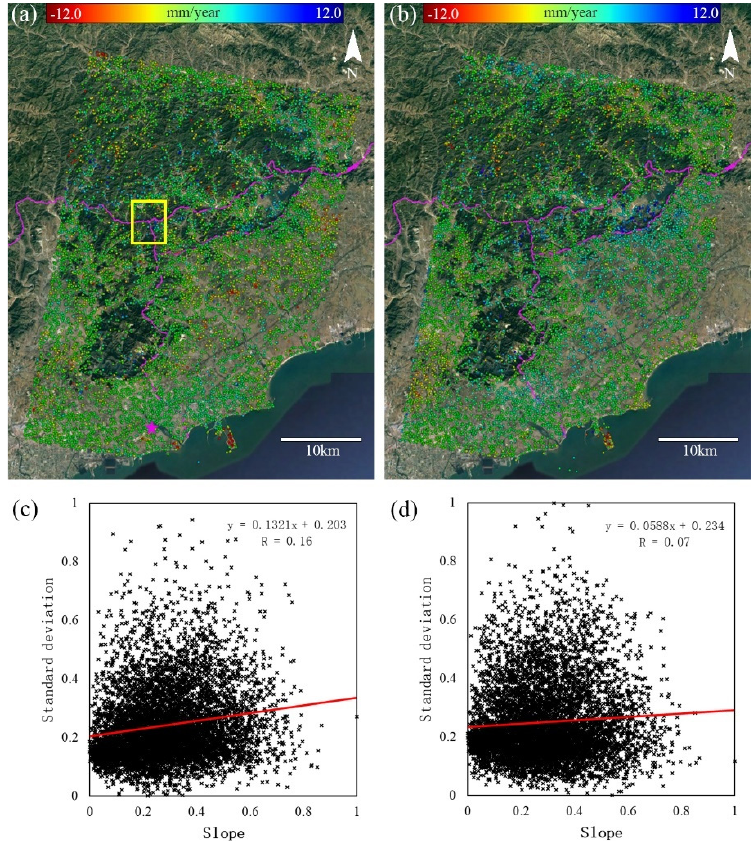
Figure 13. The deformation fields of Shanhaiguan calculated by different algorithms. ( a ) Deformation field calculated by the SBAS algorithm; ( b ) deformation field calculated by the pseudo-combination SBAS algorithm; and ( c , d ) scatter plots for the slopes and standard deviation of the respective algorithms.